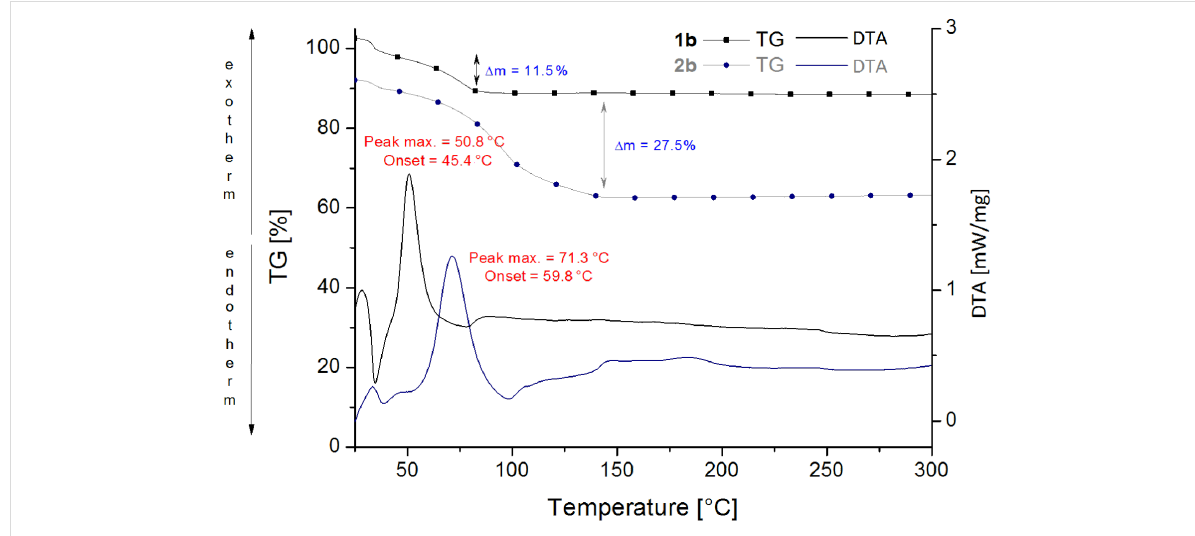
Figure 5: DTA-TGA measurements for polymerizations of DCPD with catalysts 1b and 2b ; Reaction conditions: [catalyst]:[DCPD]:[HCl]: 1:10.000:25; Temperature program: 3 °C/min.